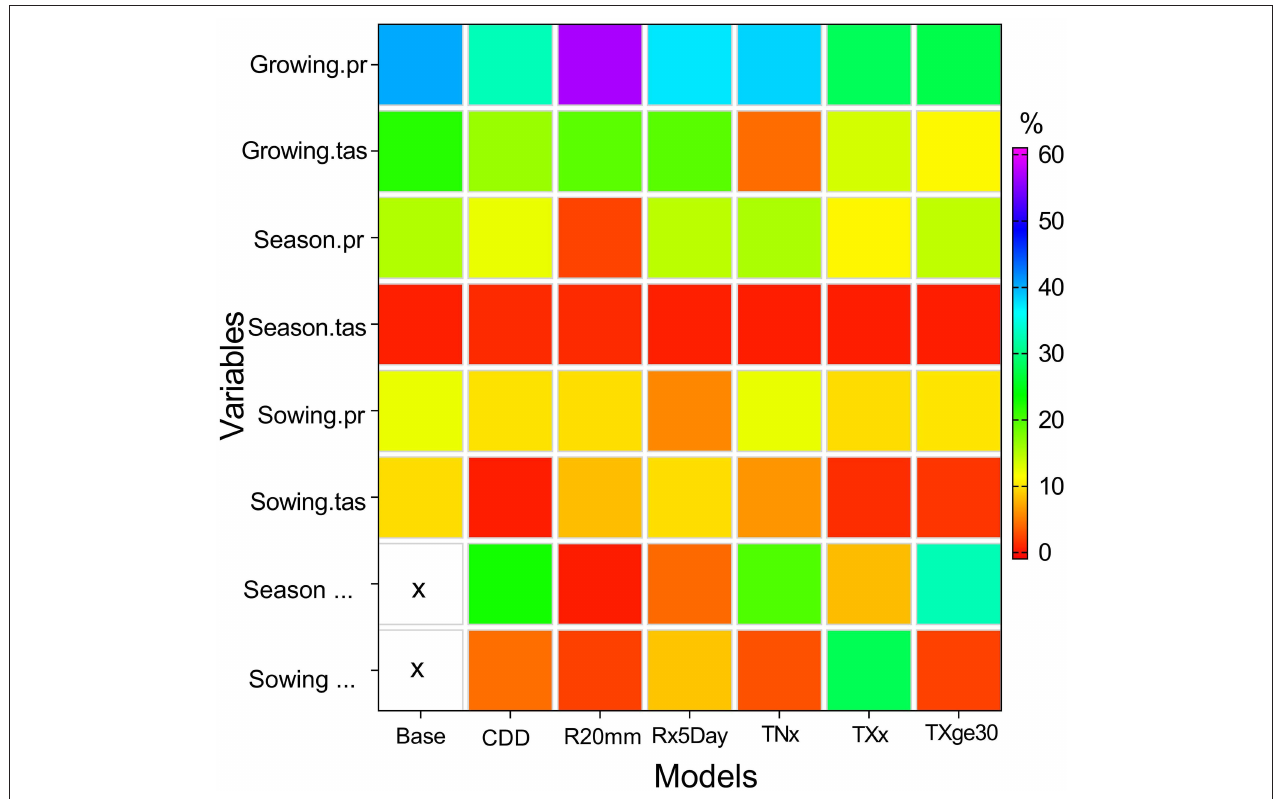
FIGURE 3 | Percent contribution of variables used in maize suitability modeling from the model variable importance. The Y axis shows first the six variables used and then the seasonal and sowing period importance values for each of the rainfall and temperature indices used, with the x showing that no other indices were used for the base model. In all cases the column values add to 100% with the green and blue shades showing more important variables for maize suitability for each model compared to the red shades which indicate non low importance of a variable.